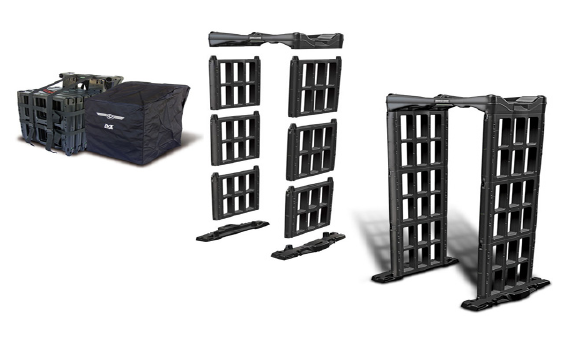
Figure 8 – Walk-through metal detector Fisher M-S С OPE Рис . 8 – Рамка - металлодетектор Fisher M-S С OPE Слика 8 – Металдетекторска врата Fisher M-S С